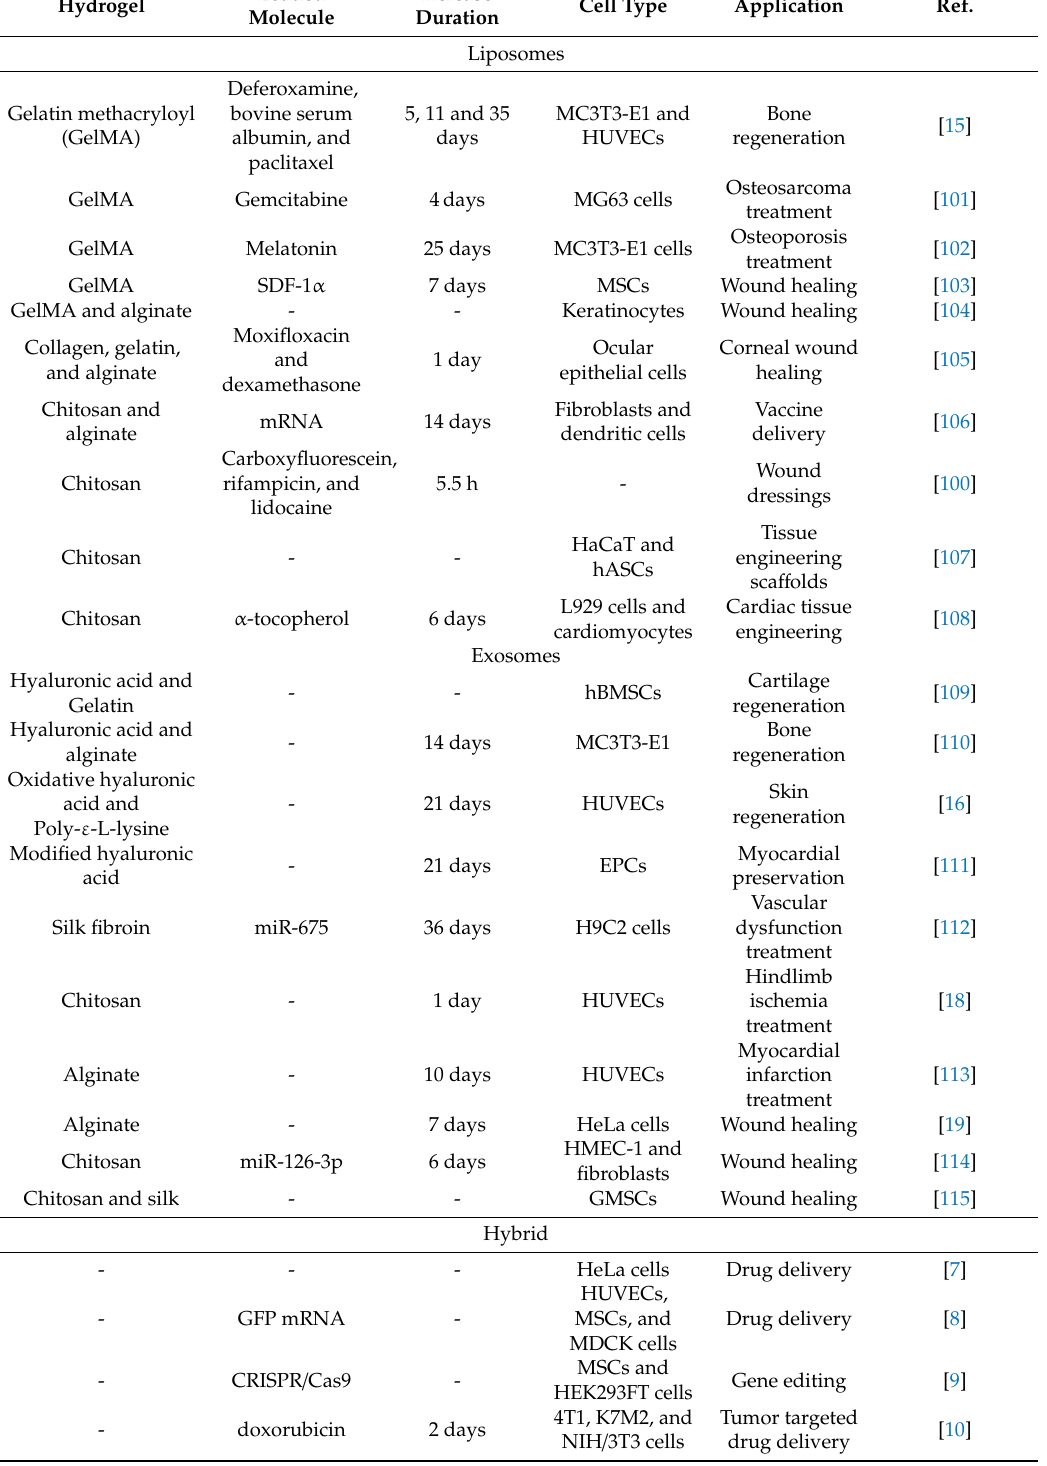
Table 1. Comparison of liposomes, exosomes, and hybrid particles embedded in natural hydrogel delivery systems and their